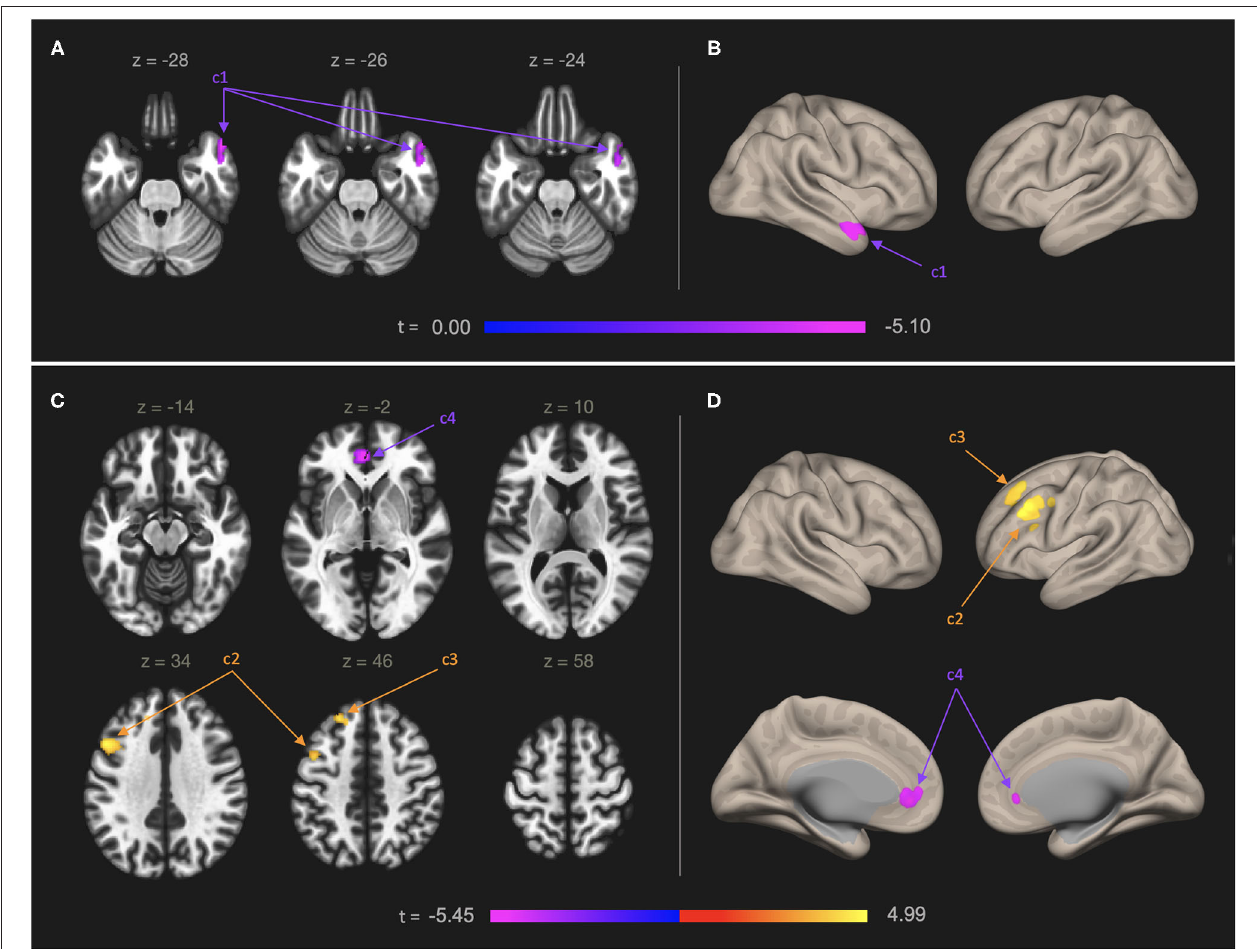
FIGURE 1 | Functional connectivity map of the right IC (A,B) and left OFC (C,D) in relation to self-reported apathy symptoms. Models were adjusted for age. Left panel: Results shown in axial slices of the brain. Right panel: A 3-dimentional rendering of the inflated brain showing the results. Numbers on the color bars indicate peak voxel t-statistics. Statistical significance was determined by cluster p-FDR < 0.05 and voxel-level threshold p < 0.001. (A,B) Self-reported symptoms of apathy were negatively associated with neural connectivity between right IC ROI and a cluster of 124 voxels in the left anterior temporal regions (cluster 1, “c1”), including the right temporal pole (84 voxels) and right anterior middle temporal gyrus (25 voxels). (C,D) Self-rated symptoms of apathy were positively associated with neural connectivity between the left OFC ROI and a cluster of 282 voxels in the left lateral prefrontal regions (cluster 2, “c2”), including left middle frontal gyrus (268 voxels) and a cluster of 123 voxels in the anterior prefrontal regions (cluster 3, “c3”), including left superior frontal gyrus (73 voxels) and the left frontal pole (34 voxels). The symptoms were negatively associated with neural connectivity between the left OFC and a cluster of 160 voxels in the anterior cingulate regions (cluster 4, “c4”), including the left paracingulate gyrus (83 voxels) and the ACC (57